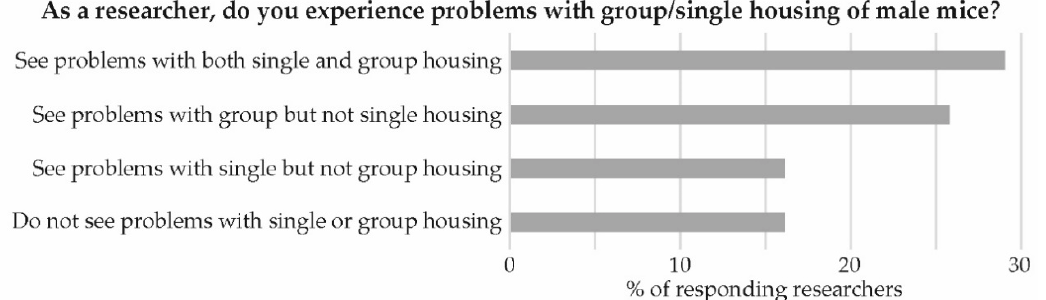
Figure 8. Reasons for single housing and problems seen by researchers. ( a ) What is the main reasons for single housing of male mice? And, ( b ) as a researcher, do you experience problems with group/single housing of male mice?